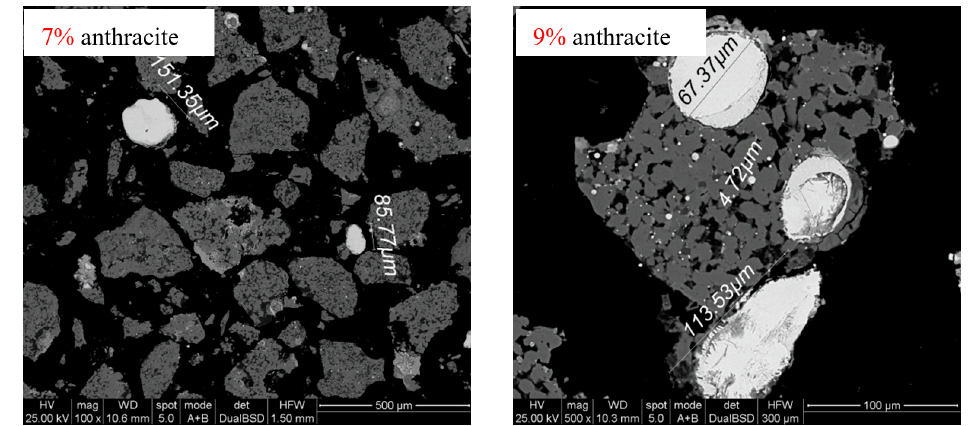
Figure 6. SEM image of the reduction calcines in 5%, 7%, and 9% anthracite.